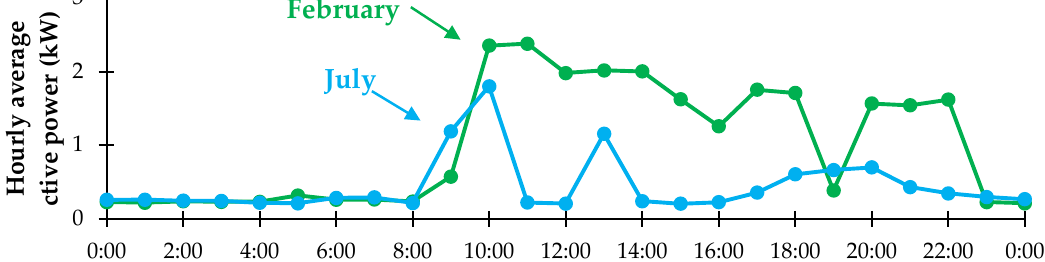
Figure 7. Load power profiles of a day in February and July. Solar irradiance and air temperature hourly data were downloaded from